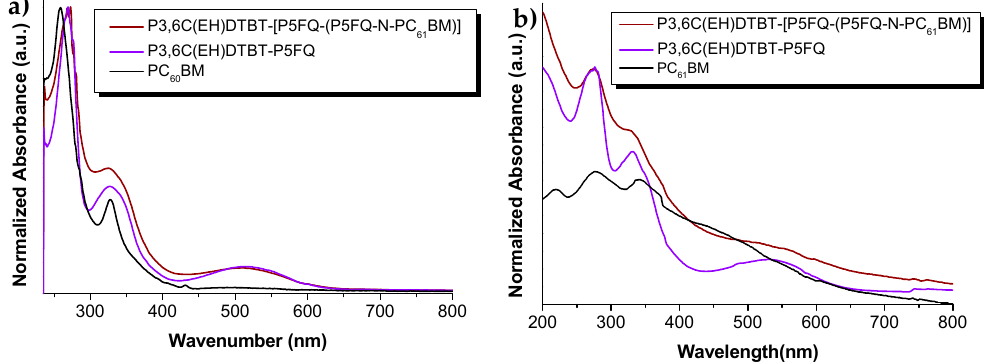
Figure 12. Normalized absorption spectra of P3,6C(EH)DTBT-P5FQ, PC 61 BM and of their hybrid P3,6C( ΕΗ )DTBT-(P5FQ-(P5FQ-N-PC 61 BM)) ( a ) in o -DCB solutions; and ( b ) in thin film form. Thin film morphology of the P3,6C( ΕΗ )DTBT-(P5FQ-(P5FQ-N-PC 61 BM) was investigated using